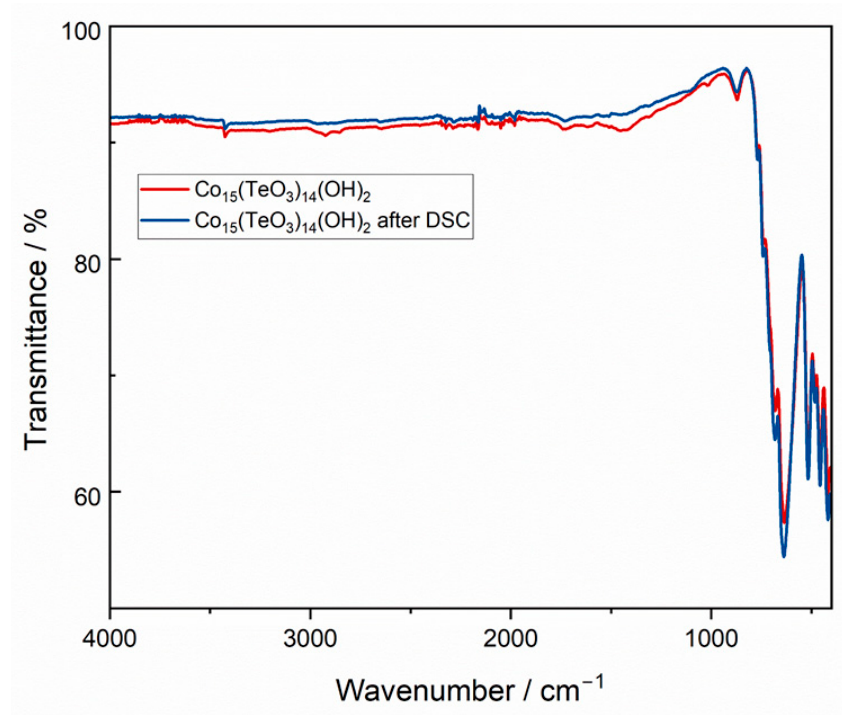
Figure 8. IR spectrum of Co 15 (TeO 3 ) 14 (OH) 2 prior and after heat treatment at 580 °C. Co 2 (TeO 3 )(OH) 2 shows two OH stretching vibration bands at 3570 cm − 1 and at 3202 cm − 1 , respectively. The first band is associated with the OH group (O1) without an acceptor group for hydrogen bonding, which explains the rather sharp band profile and the high wavenumber. In comparison, the broad band and the red-shift of about 370 wave numbers for the second OH vibration (O2) indicates a clear participation in a hydrogen bonding interaction of a medium–strong nature. The application of Libowitzky’s empiri- cal correlation between OH stretching and O − H···O hydrogen bond lengths [39] results in an expected O···O distance of 2.705 Å, deviating only slightly from the experimental value of 2.730 Å as determined from the X-ray diffraction study. The bending modes for the two OH vibrations are observed at 1016 and 917 cm − 1 , in agreement with other solids contain- ing OH groups, e.g., for various zinc hydroxy compounds, where these bands were ob- served between 1015 and 755 cm − 1 [40], or for the phyllomanganate birnessite that contains Mn II − OH and Mn III − OH groups, the bending vibrations of which were assigned in the range 1170–900 cm − 1 [41]. In agreement with the crystal structure of Co 15 (TeO 3 ) 14 (OH) 2 , which comprises only one OH function (O8), the IR spectrum shows one OH stretching vibration band at 3425 cm − 1 , albeit with a very weak intensity. The latter might be correlated with the low amount of OH in the compound (two OH groups related to an overall of 75 atoms in the formula). The position of this band suggests a significantly weaker hydrogen bonding interaction than that for the second OH group in Co 2 (TeO 3 )(OH) 2 . The correlation function reveals an expected value of 2.817 Å. In fact, a possible O acceptor atom (O3) is located at 2.877 Å from O2. However, the corresponding (H)O8···O3 donor···acceptor group is not associated with an interpolyhedral distance (as usual) but is part of the [Co3O 5 (OH)] polyhedron, which makes a direct participation of O3 in hydrogen bonding unlikely. Without a clear localization of the corresponding H atom, the true nature of the hydrogen bonding situa- tion thus remains unclear. The bending mode of the OH vibration at 871 cm − 1 is in the same range as the ones given above. The lower wavenumber part of the spectra is dominated by the Te − O vibrations, with a typical range between 800 and 600 cm − 1 for the Te − O stretching vibrations [42], with the